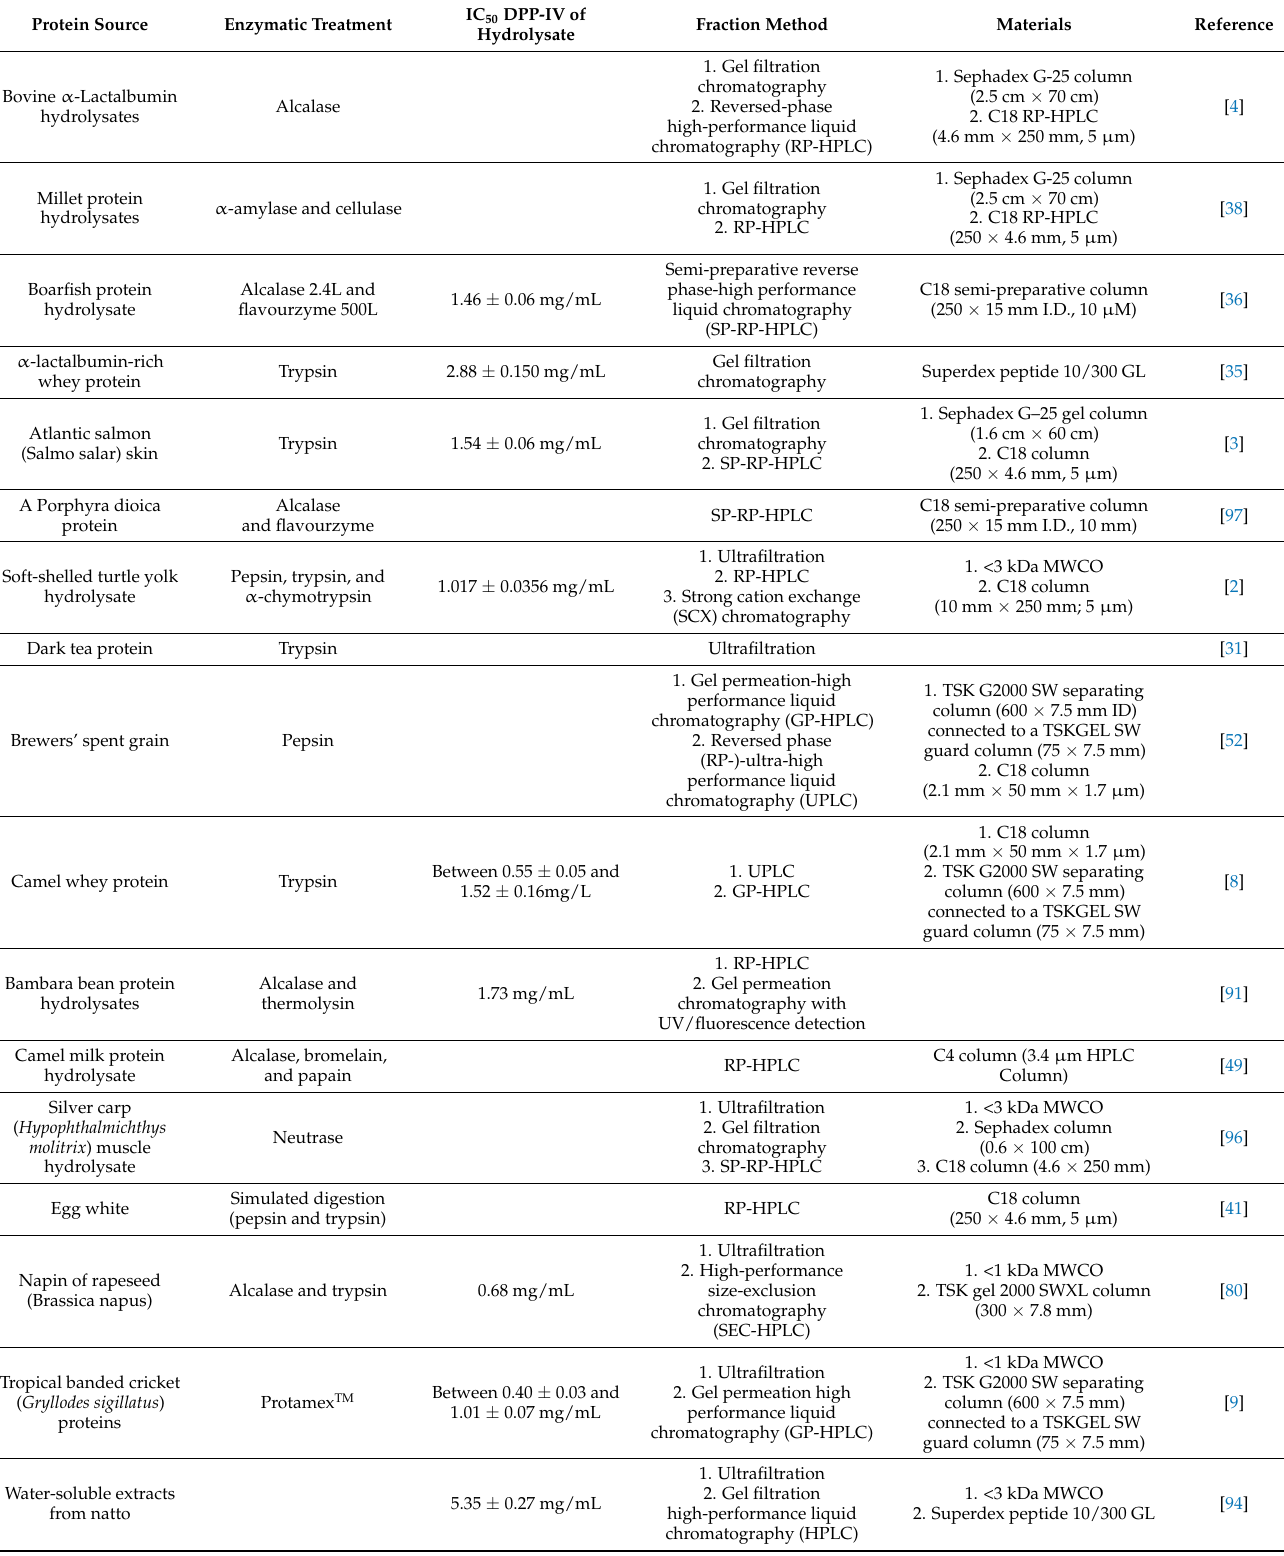
Table A2. Recently reported examples of methods on DPP-IV inhibitory peptides fractionation and purification